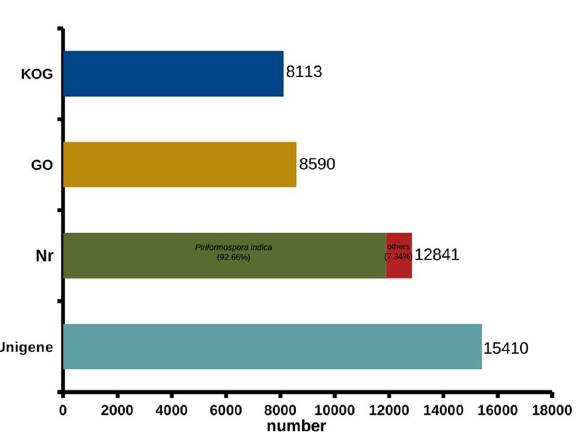
Figure 3. Functional characteristics of homology search of P. indica unigenes. Assembled unigenes were mapped against non-redundant (nr), gene ontology (GO), and EuKaryotic Orthologous Groups (KOG) database. Total 12,841 unigenes were mapped to their homologous nr protein sequences out of which 92.65% (11,898) were matched to P. indica . A total of 8590 unigenes were assigned to different GO terms and 8113 unigenes were mapped different KOG